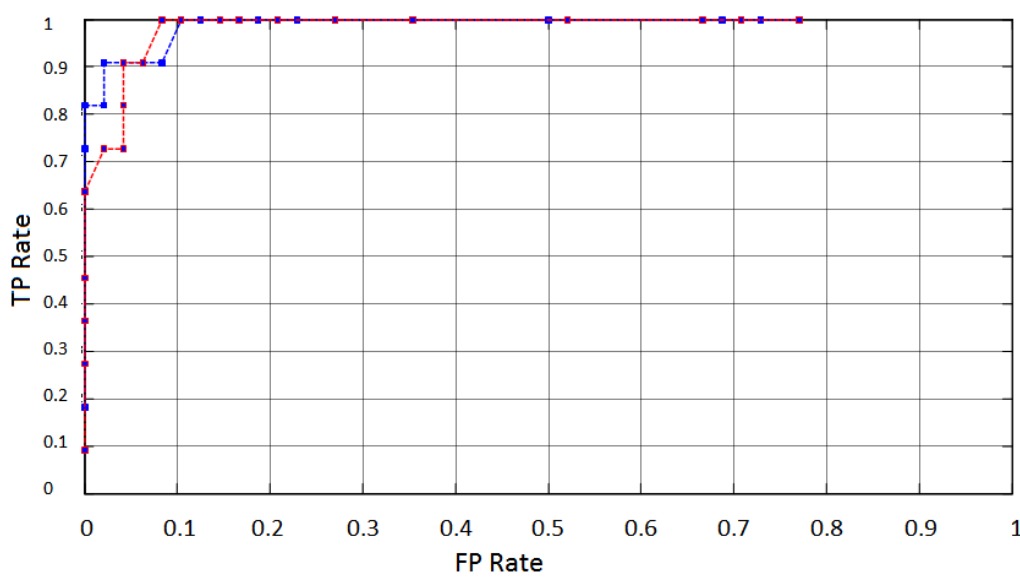
Figure 18. Average ROC curves obtained through measurements from AF4 (blue) and AF3 (red) electrodes.